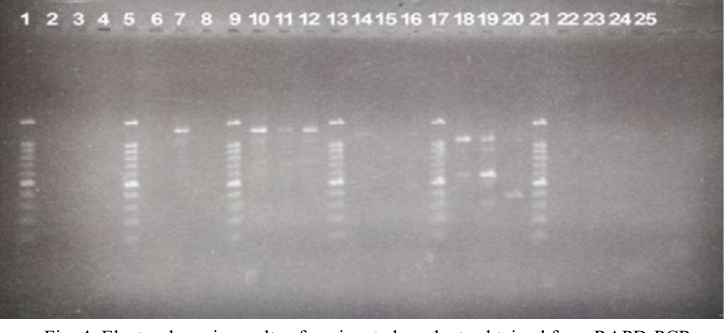
Fig. 4: Electrophoresis results of conjugated products obtained from